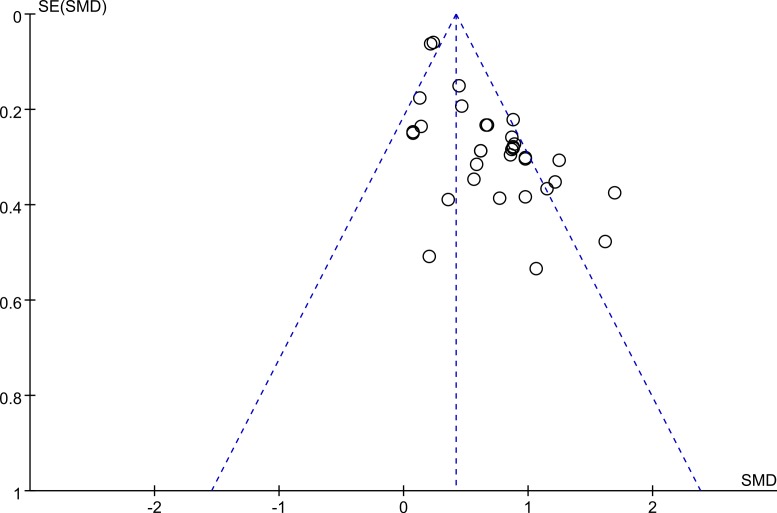
Funnel plot.Funnel plot for evaluation of publication bias in the included studies on the association between serum IL-6 concentrations and COPD. COPD, chronic obstructive pulmonary disease; SMD, standard mean difference.